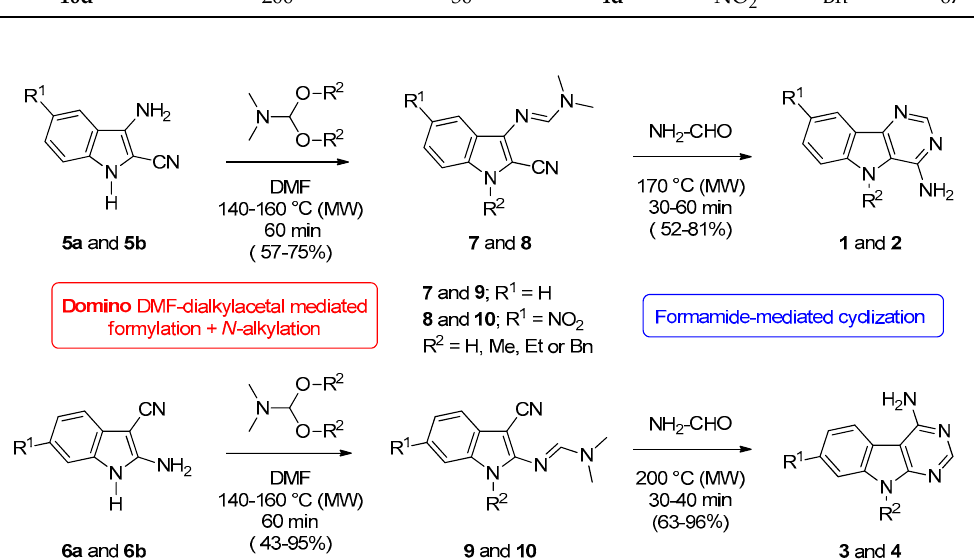
Table 1. Synthesis of series 1 , 2 , 3 , and 4 : temperature, reaction time, and isolated yields.